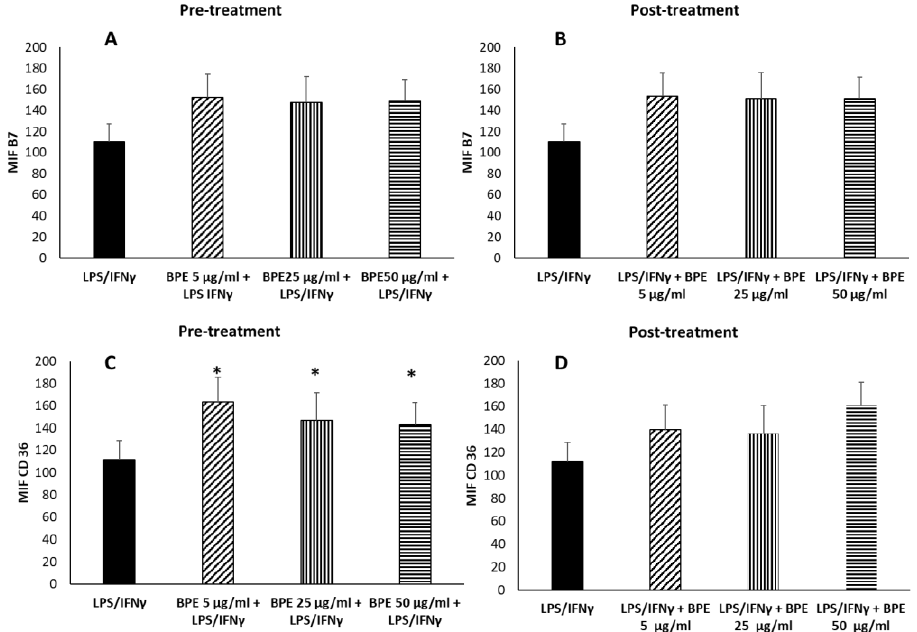
Figure 9. Effect of BPE pretreatment ( A , C ) and posttreatment ( B , D ) on macrophages’ polarization induced by LPS/IFNγ. THP-1-derived macrophages were pretreated for 24 h with the indicated concentrations of BPE before LPS/IFNγ stimulation ( A , C ) or posttreated with BPE after LPS/IFNγ (B and D). After stimulation, cells were labelled with FITC mouse antihuman B7 and PE mouse antihuman CD36. Labelled cells were analyzed by cytofluorimeter. Results are expressed as Mean Intensity Fluorescence (MIF). The statistical analysis was performed with a two-tailed Student’s t -test. * p < 0.05 (BPE+LPS/IFNγ -treated cells vs. LPS /IFNγ -treated cells).